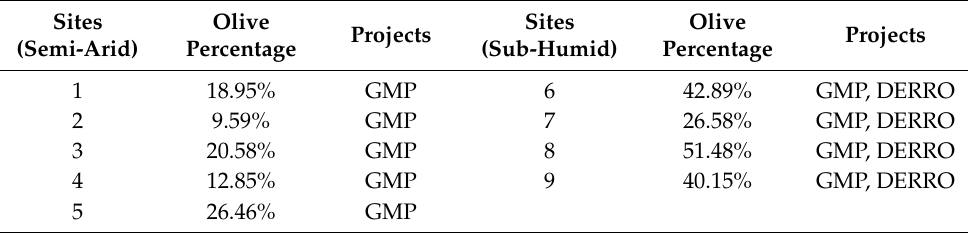
Figure 1. Map of the Northern part of Morocco and study sites. Subfigures show representative precipitation relative to the average from 1980–2018 (CHIRPS) and example images from DigitalGlobe (spatial resolution of 0.5 m). Red dots show nine sites of olive orchards from paper-based maps available from the Green Morocco Plan. Table 1. Site-specific information. Non-olive includes all other land cover types except for olives, such as other vegetation, barren lands, and croplands etc. Olive percentages are derived from visual interpretation of DG imagery (see Section